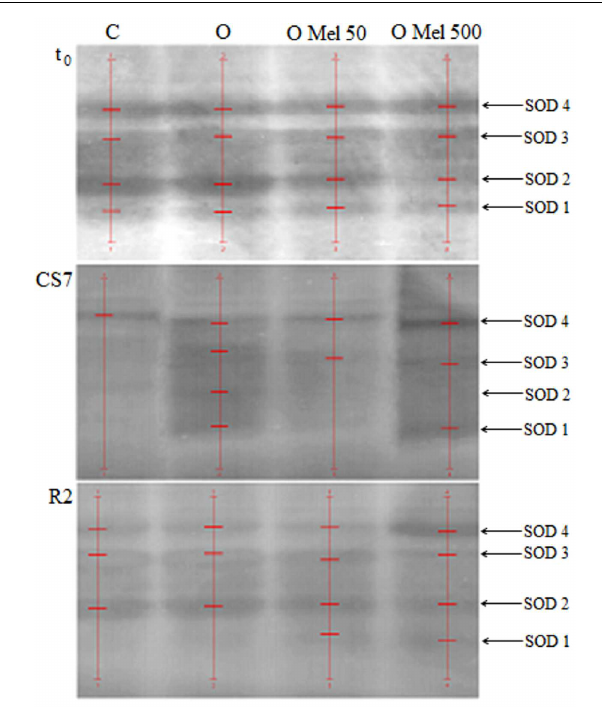
FIGURE 4 | Native gels with superoxide dismutase (SOD) isoenzymes extracted from embryonic axes of the cucumber seeds. The axes were isolated from control seeds (C) and those osmoprimed without (O) and with melatonin at concentrations: 50 µ M (O Mel 50) and 500 µ M (O Mel 500). The seeds were germinated in water at 10 ◦ C in darkness for 7 days (CS7), and then subsequently regenerated at 25 ◦ C for 2 days (R2). Enzymes were also estimated in the axes isolated from the seeds germinated 24 h in optimal conditions 25 ◦ C (t 0 ). The stripes of enzyme isoforms were detected (red lines) and estimated by densitometric analysis of gels using QuantityOne 1-D Analysis Software v. 4.6.9 (BioRad). In the case of SOD native gels their original image – dark gels with light strips – ware automatically transformed to their negative versions by software.